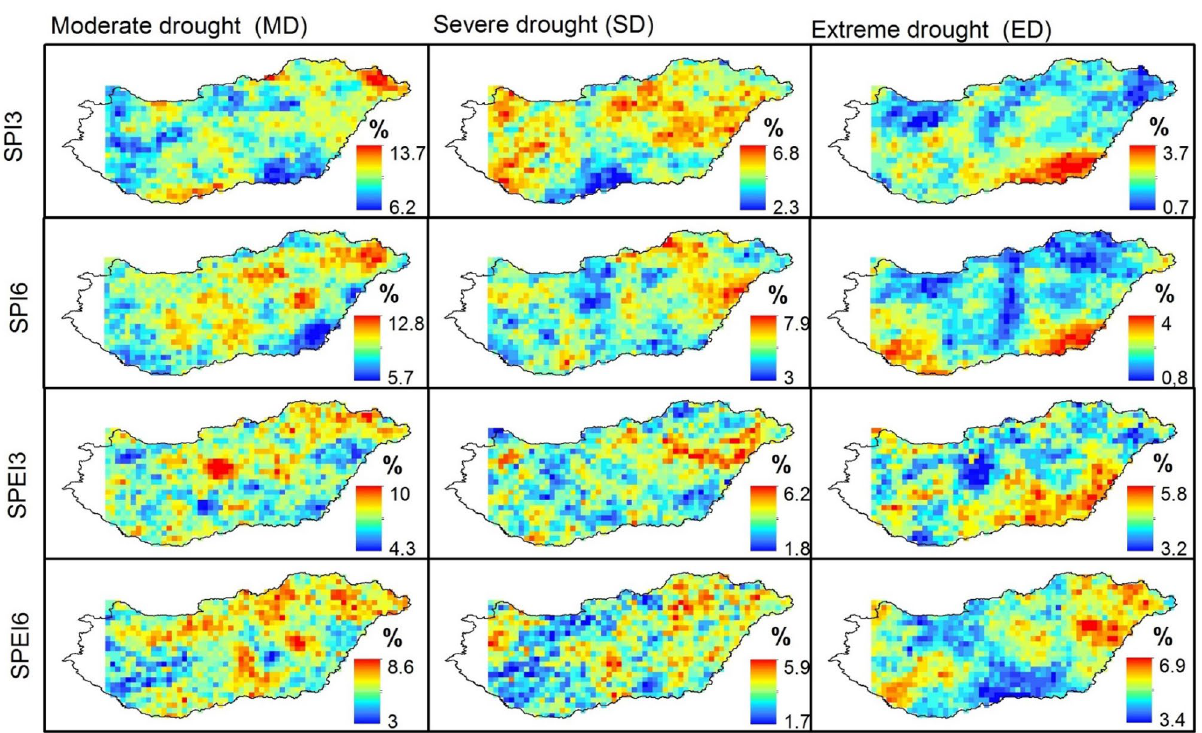
Figure 5. Spatial distribution of tdd of SPI/SPEI-3-6 between 1961 and 2010 over Hungary (maps were generated using ArcGIS 10.5 (https:// www. esri. com/ en- us/ about/ about- esri/ overv